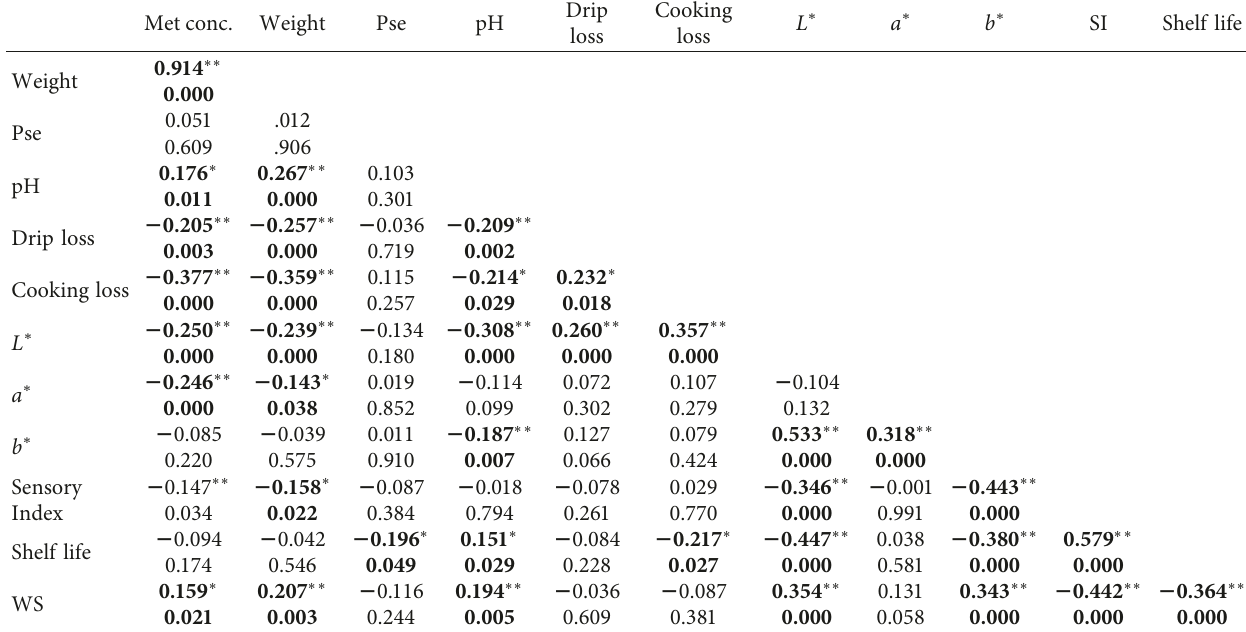
Table 3: Spearman’s ρ correlation indices and p-values of meat quality parameters 24h after slaughter. Met